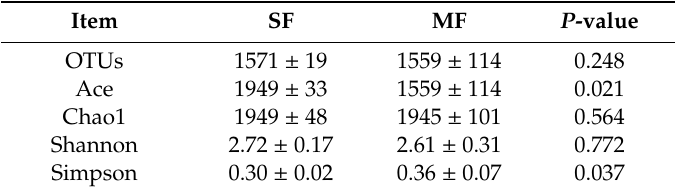
Table 2. Alpha diversity measures of the bacterial communities in fermented feed samples.